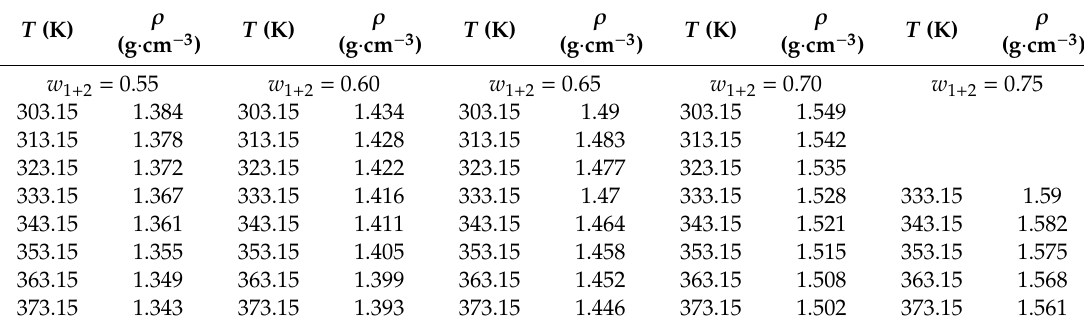
Table A3. Density at absorbent mass fraction w of the system LiBr (1) + [BMIM]Cl (2) + H 2 O (3) at p = 0.1 MPa a .